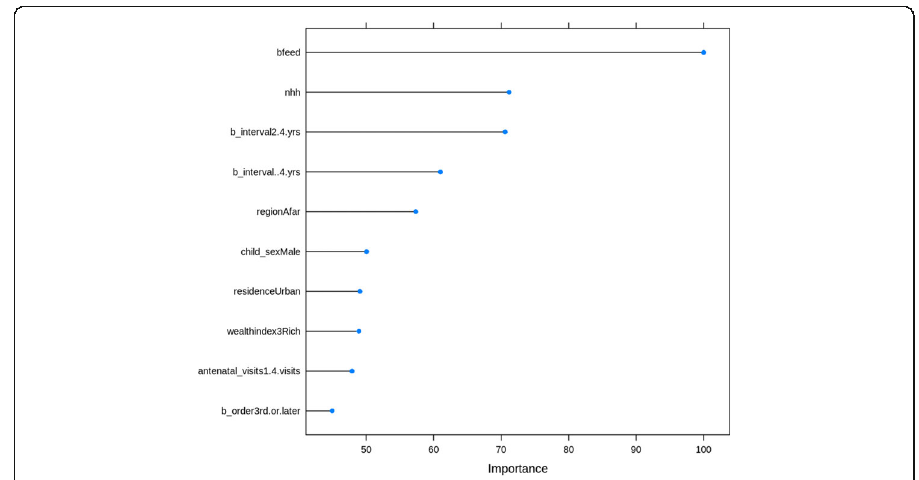
Fig. 4 Variable importance measures for logistic regression model